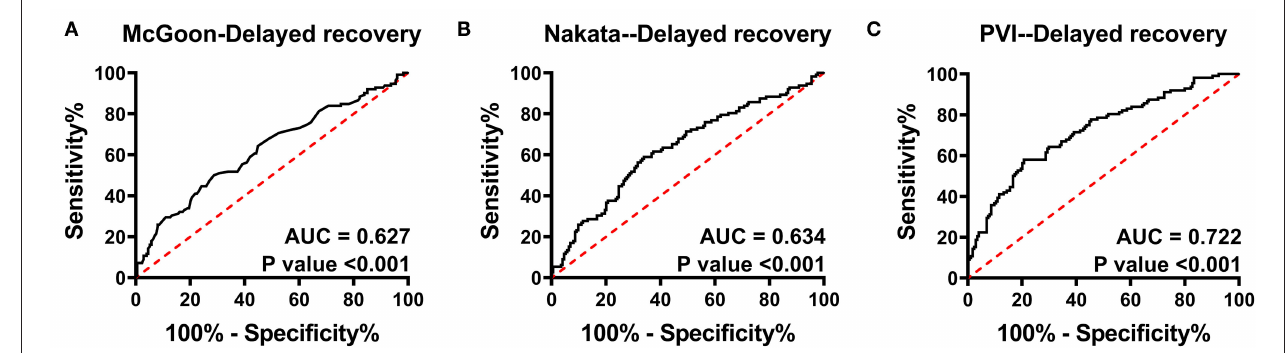
FIGURE 2 | Receiver operating characteristic curve analysis for delayed postoperative recovery. (A–C) indicate the predictive value of the McGoon ratio, Nakata index, and PVI for delayed recovery, respectively. The AUC of PVI was the largest. AUC, area under the ROC curve; PVI, pulmonary vein index. p < 0.05 indicates statistical